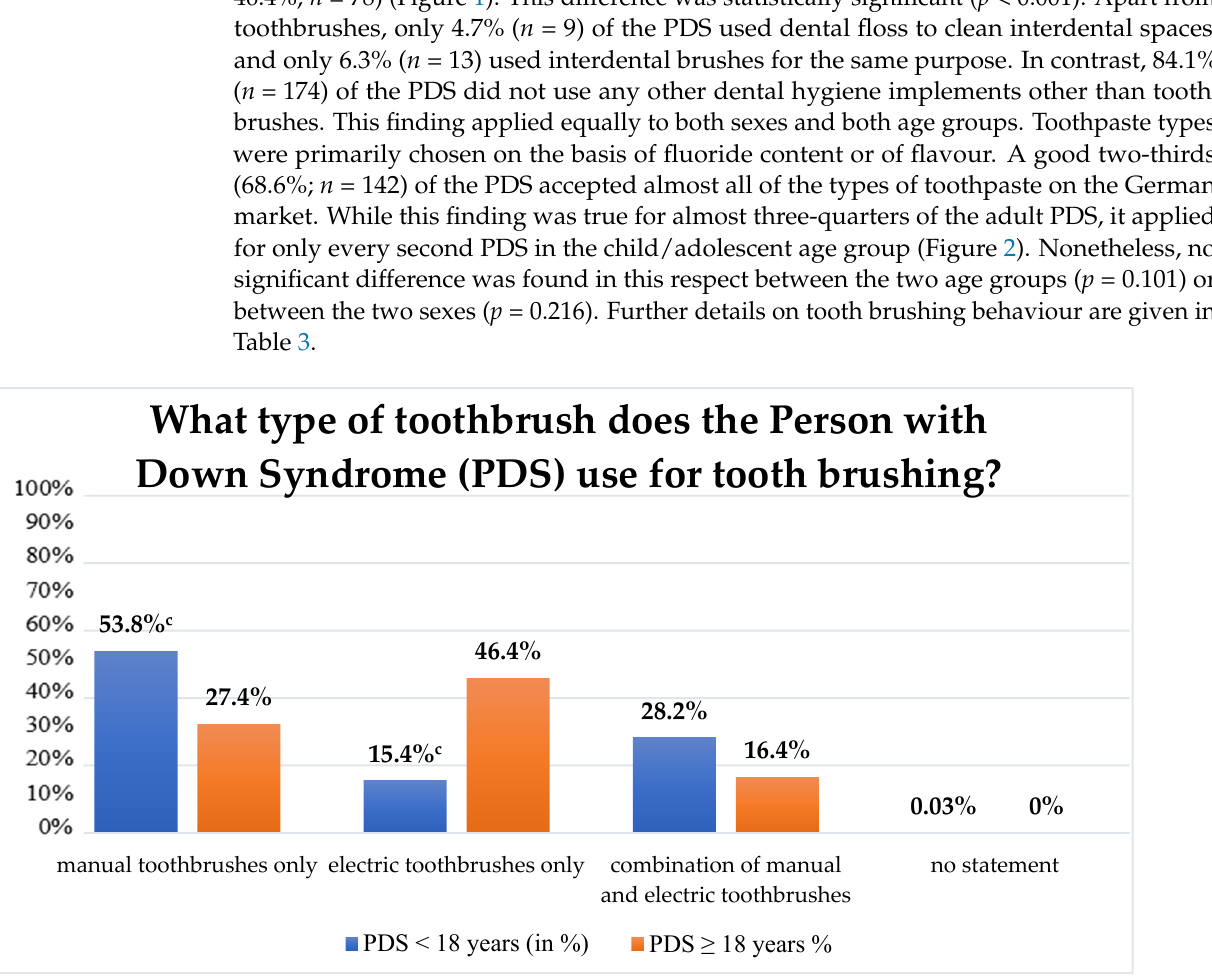
Figure 1. Percentage distribution of toothbrush types used by children and adolescents with Down Syndrome and by adults with Down Syndrome ( c — p = 0.001).